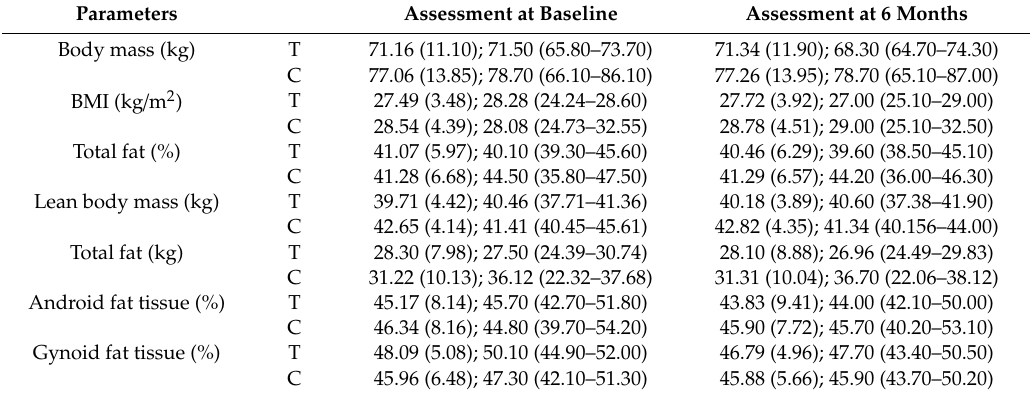
Table 1. Somatic features before and after the intervention in the training and control groups.